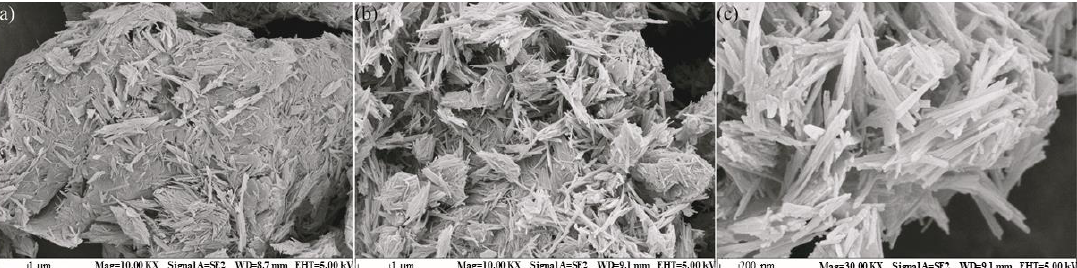
Figure 3. Scanning electron micrographs of: ( a ) palygorskite (10,000 × ), ( b ) modified palygorskite (10,000 × ), and ( c ) EreB@modified palygorskite (30,000 ×